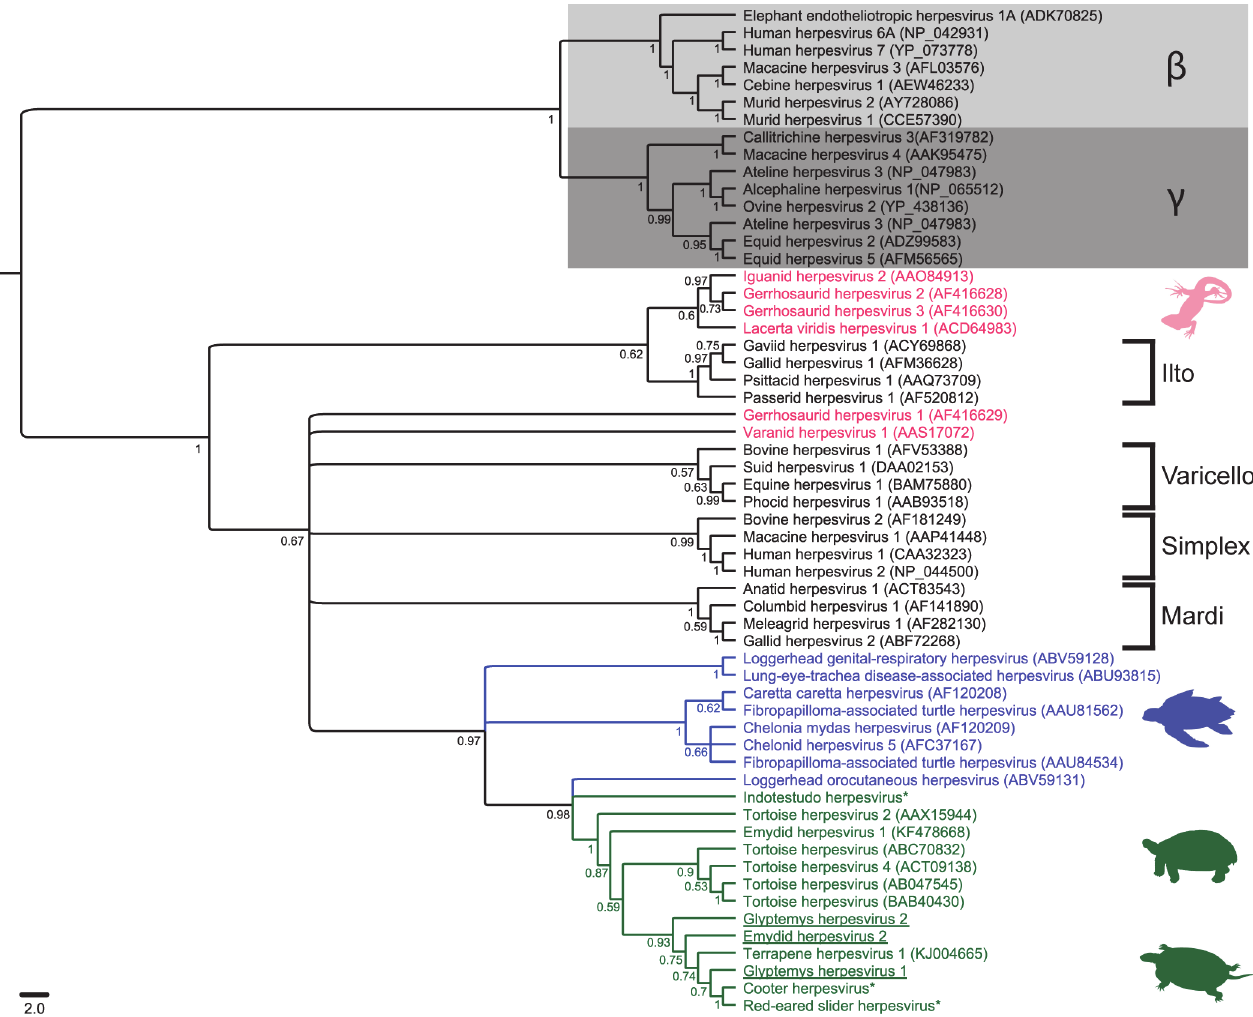
Fig 1. Midpoint-rooted Bayesian phylogenetic tree of predicted amino acid sequences of herpesviral DNA-dependent DNA polymerases. Bayesian posterior probabilities are shown at branch points. Glyptemys herpesvirus 1 and 2 and Emydid herpesvirus 2 are underlined. Herpesviruses of freshwater and terrestrial turtles and tortoises are shown in green; herpesviruses of marine turtles are shown in blue and other reptile herpesviruses are shown in red. Brackets demarcate Alphaherpesvirinae genera Ilto- , Varicello- , Simplex and Mardiviridae . The Betaherpesvirinae are highlighted by a light grey box, and the Gammaherpesvirinae by a dark grey box. Genbank accession numbers are shown in parentheses following the virus name. Sequences not published in Genbank are marked with an asterisk ( * ).